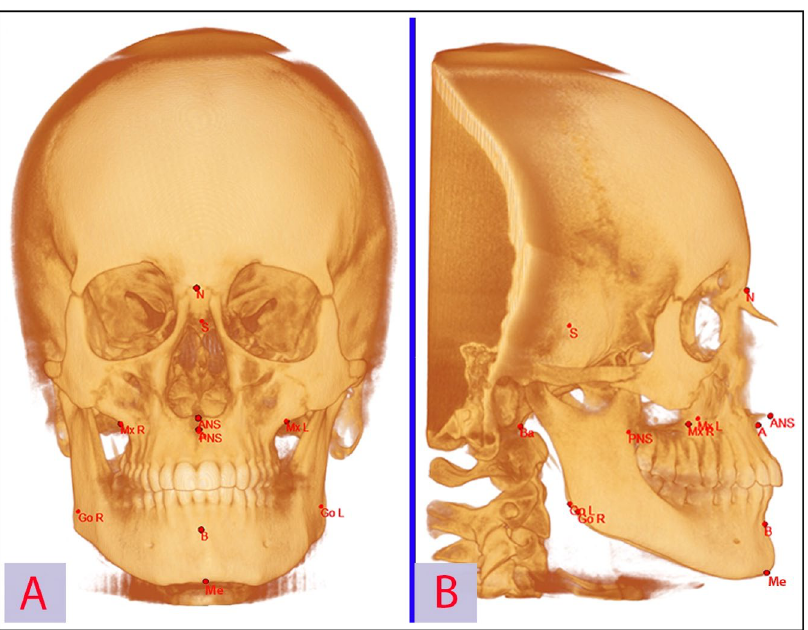
Figure 4. Cephalometric landmarks used in the present study were: S = Sella (centre of sella turcica); N = Nasion (most anterior limit of the frontonasal suture on the frontal bone in the facial midline); Ba = Basion (The most anterior point of the foramen magnum); ANS = Anterior nasal spine (the tip of the anterior nasal spine); PNS = Posterior nasal spine (the most posterior point on the bony hard palate); A = Point A of Downs (Deepest bony point on the contour of the premaxilla below ANS); B = Point B of Downs (Deepest bony point of the contour of the mandible above pogonion); Me = Menton (most inferior point of mandibular symphysis); GO l/r = left/right Gonion points (located at the most posterior inferior point of the gonial angle of the mandible); MX l/r = left/right maxillare (the deepest point of the concavity formed by the lateral wall of the maxilla and the inferior border of the zygomatic process of the maxilla).